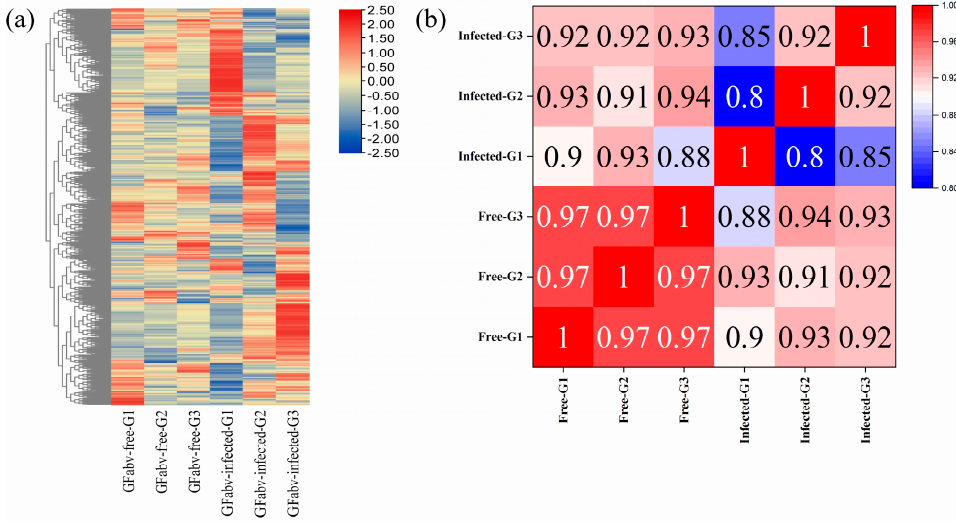
Figure 7. PCA, heatmap, and correlation analysis of metabolites in berries. ( a ) Clustering heat map of all metabolites. Red represents up-regulation, and blue represents down-regulation; ( b ) Pearson correlation coefficients of the six berry samples.